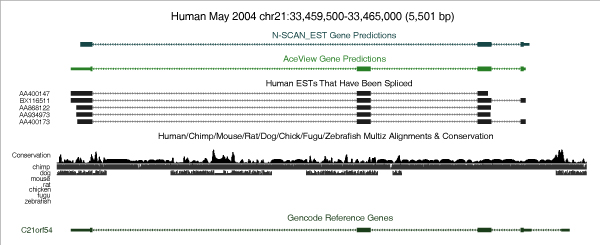
A gene where N-SCAN_EST predicts three out of the four exons right. All other programs except AceView do not predict anything in that locus. N-SCAN_EST missed an exon even though there is EST evidence for it. We believe that lack of conservation overwhelmed the EST evidence for that exon. (Screen shot obtained from UCSC Genome Browser web site [23].)